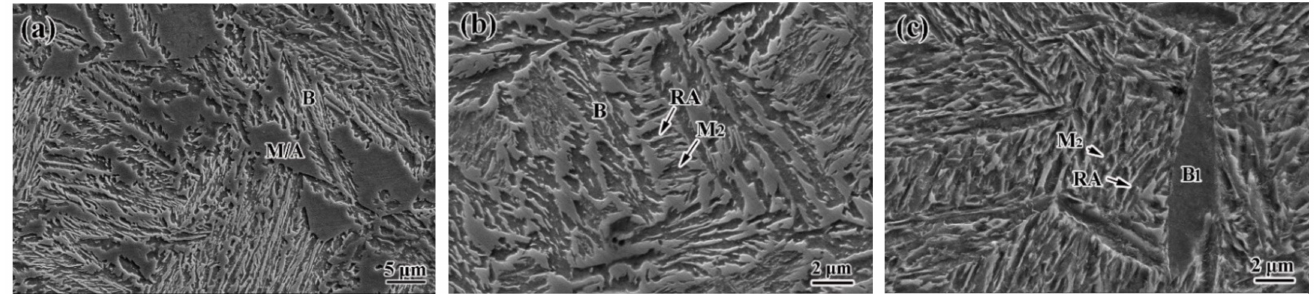
Figure 1. Microstructure of ( a ) BAT [28], ( b ) DABT and ( c ) BQ&P samples; B: bainite, B l : leaf-shaped bainite, M/A: martensite/austenite, M 2 : carbon-depleted martensite, RA: retained